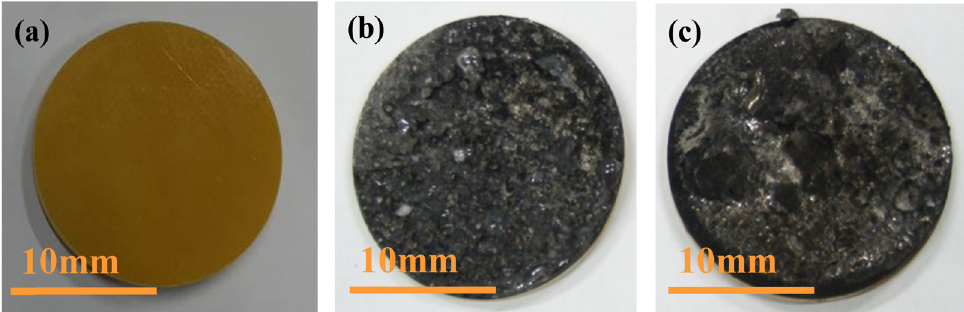
Figure 1: Digital photographs of the prepared quartz/epoxy composite before ( a ) and after laser ablation with 452 W · cm − 2 power intensity for 5 s ( b ) and 226 W · cm − 2 for 10 s ( c )